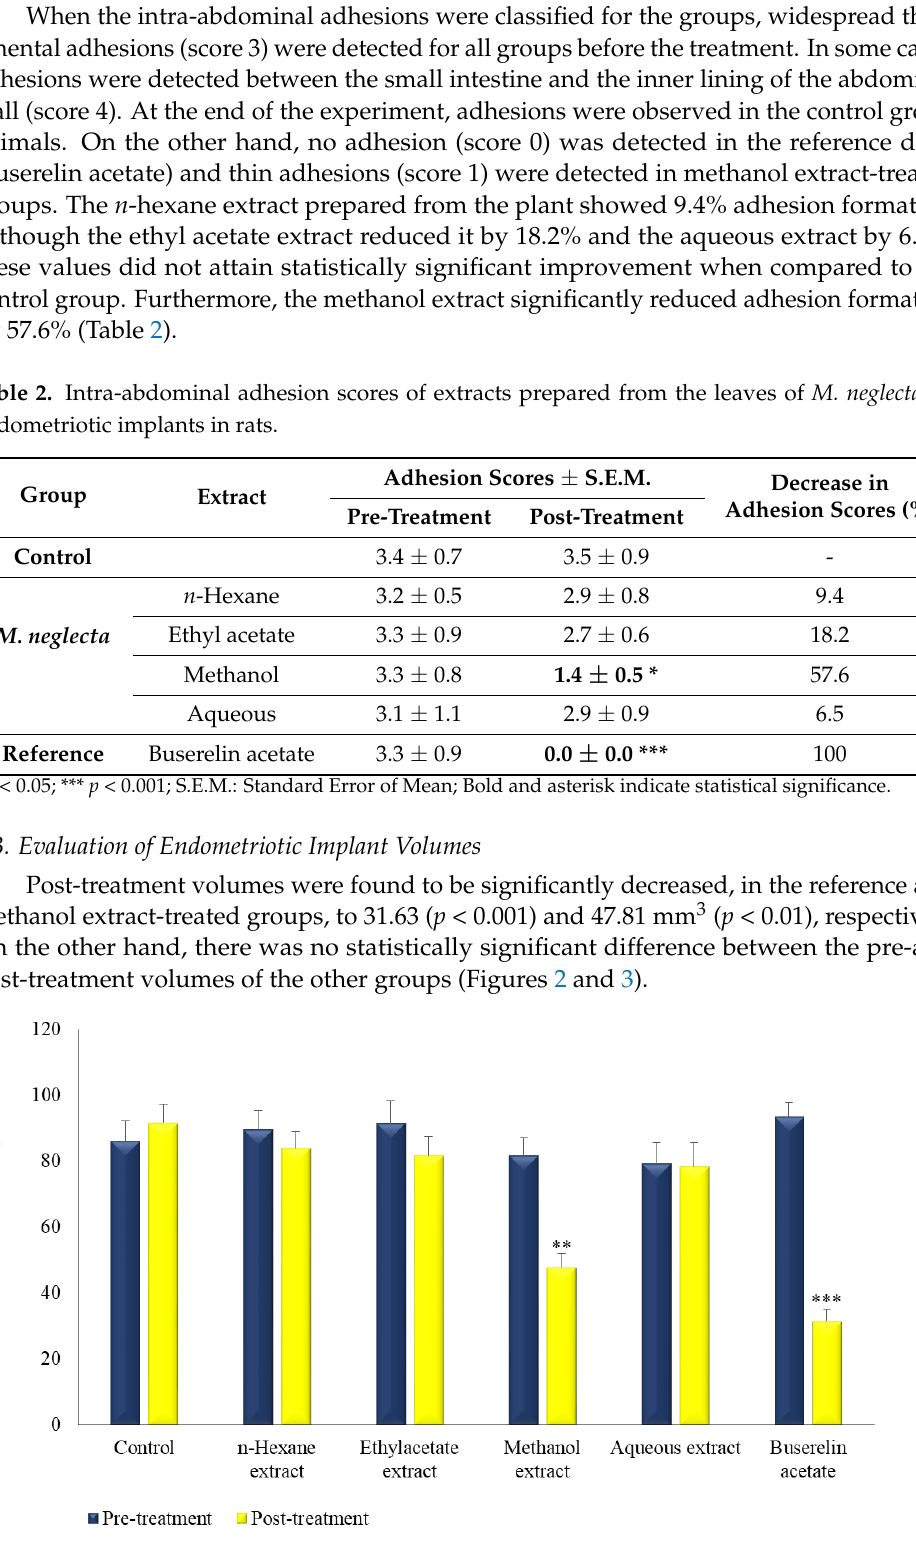
Figure 2. The effect of extracts prepared from the leaves of M. neglecta on endometriotic implant volumes in rats. ** p < 0.01, *** p < 0.001.